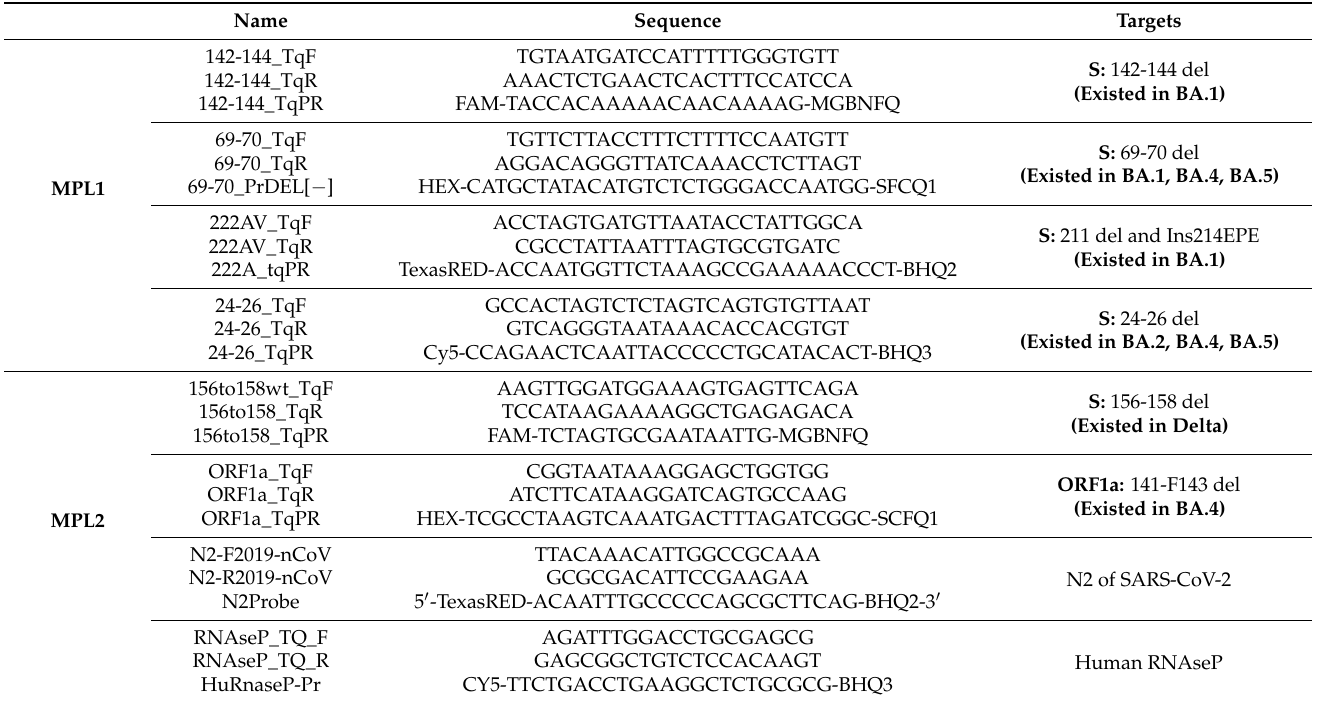
Table 1. The sequences of the designed primers, probes, and positive controls specific for the different deletion